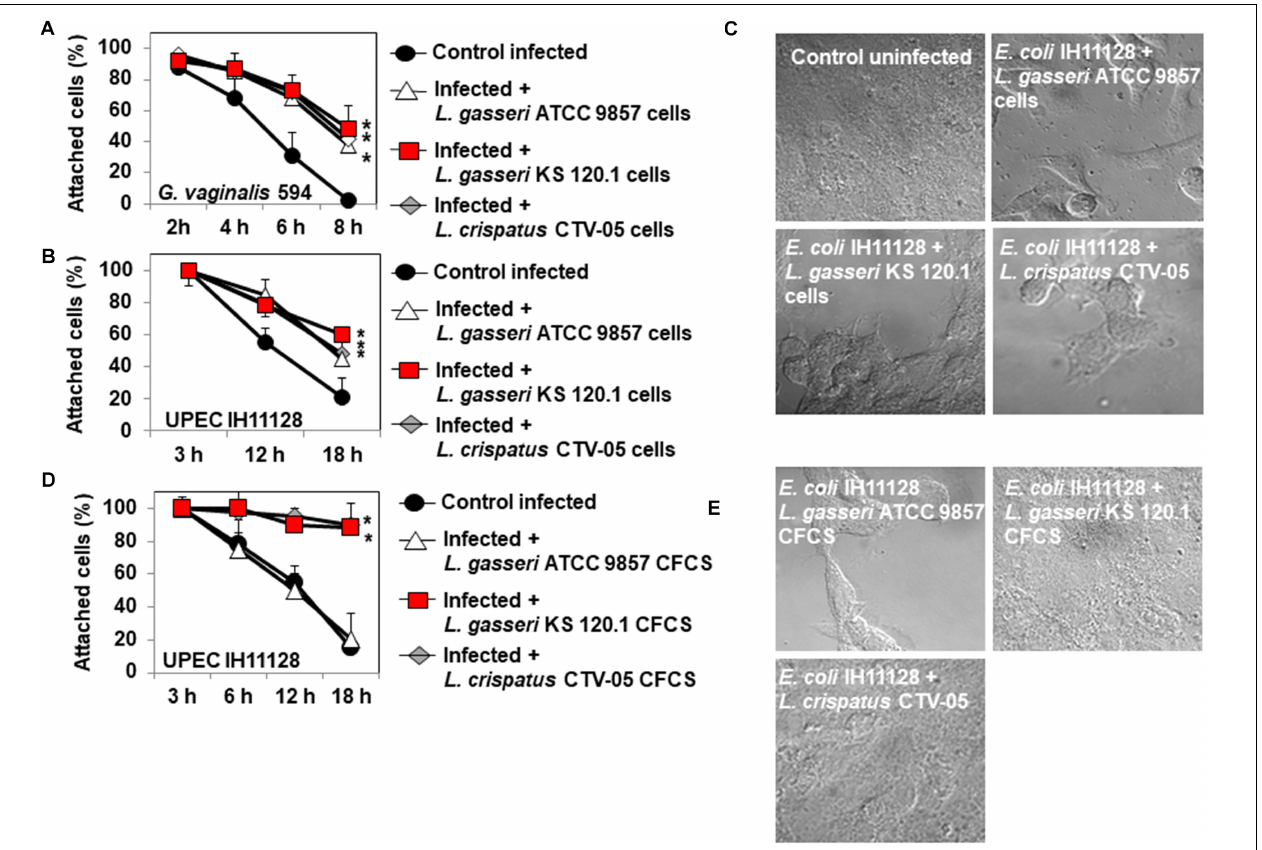
FIGURE 5 | Protective effect of cells and CFCSs of L. gasseri ATCC 9857, L. gasseri KS 120.1, or L. crispatus CTV-05 strains against the cytotoxic activities of BV-associated G. vaginalis 594 and preterm labor and recurrent cystitis-associated E. coli IH11128. (A) Quantification of time-dependent G. vaginalis 594-induced cell-detachment in the presence, or not, of pre-colonizing Lactobacillus cells. (B) Quantification of time-dependent UPEC IH11128-induced cell detachment, in the presence, or not, of pre-colonizing Lactobacillus cells. (C) Micrographs illustrating the partial inhibition of UPEC IH11128-induced cell detachment in the presence of pre-colonizing Lactobacillus cells. (D) Quantification of cell detachment in cell monolayers infected with UPEC IH11128, showing the total inhibition of cell detachment in the presence L. gasseri KS 120.1 or L. crispatus CTV-05 CFCSs and the lack of inhibition in the presence of L. gasseri ATCC 9857 CFCS. (E) Micrographs illustrating the entire inhibition of UPEC IH11128-induced cell detachment in the presence L. gasseri KS 120.1 or L. crispatus CTV-05 CFCSs. Phase-contrast micrographs are representative of two separate experiments. The number of attached cells was monitored by phase-contrast light microscopy. Each value shown is the mean ± SD from three experiments. Student t -test, ∗ p < 0.01 compared to G. vaginalis 594 or UPEC